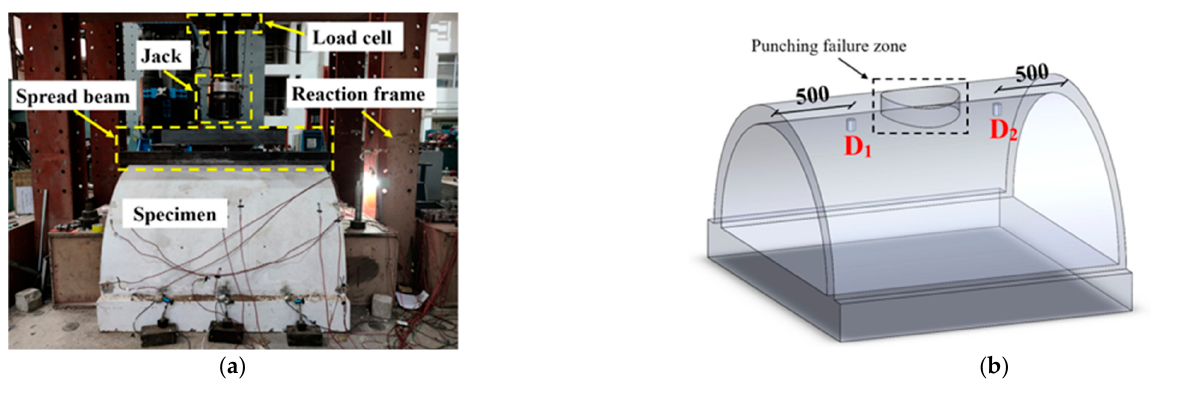
Figure 4. Test setup: ( a ) Scene photo; ( b ) Layout of displacement sensors (unit: mm). Table 3. Test program.